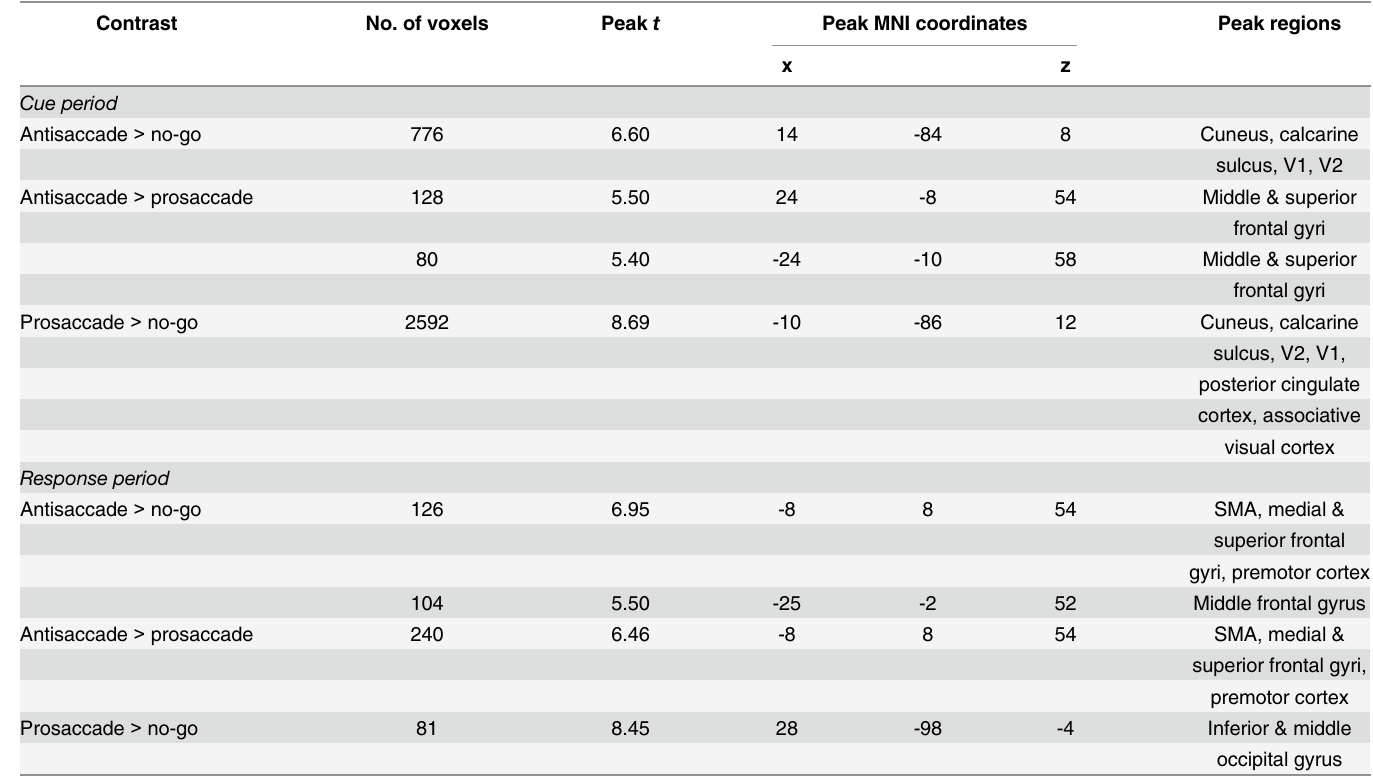
Table 6. Significant within groups contrasts for the Prosaccade/Antisaccade/No-Go task for Anorexia Nervosa participants.